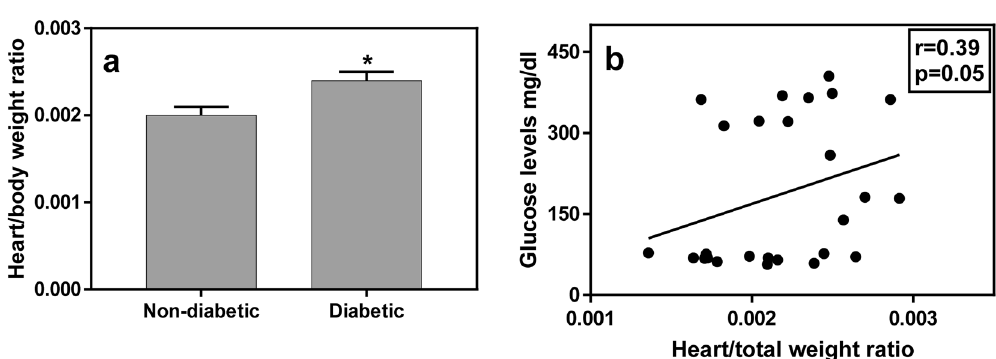
Figure 3. Diabetic animals exhibited a higher heart/total body weight ratio than the non-diabetic ones (a, N = 13/group). There was a significant correlation between the heart/total body weight ratio and glucose levels in the GTT (b, N = 26). * Signifies p < 0.05 for the difference between the